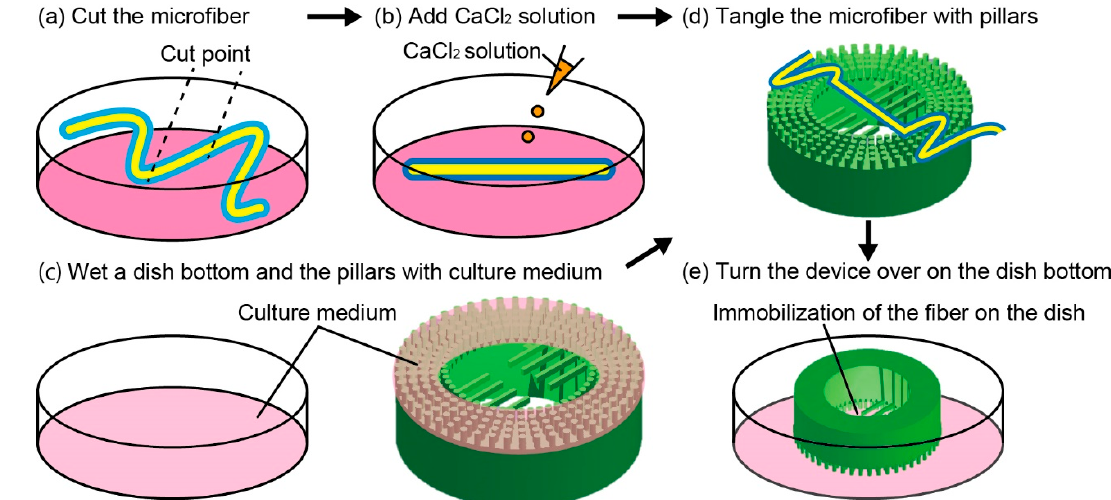
Figure 3. Process flow of immobilization of an adipocyte microfiber with an anchoring device: ( a ) Cut the microfiber with scissors; ( b ) Add CaCl 2 solution to increase the strength of the alginate gel layer; ( c ) Wet a dish bottom and the pillars with a culture medium; ( d ) Tangle the microfiber with pillars using a pair of tweezers; ( e ) Turn the device over on the dish bottom for a clear observation.